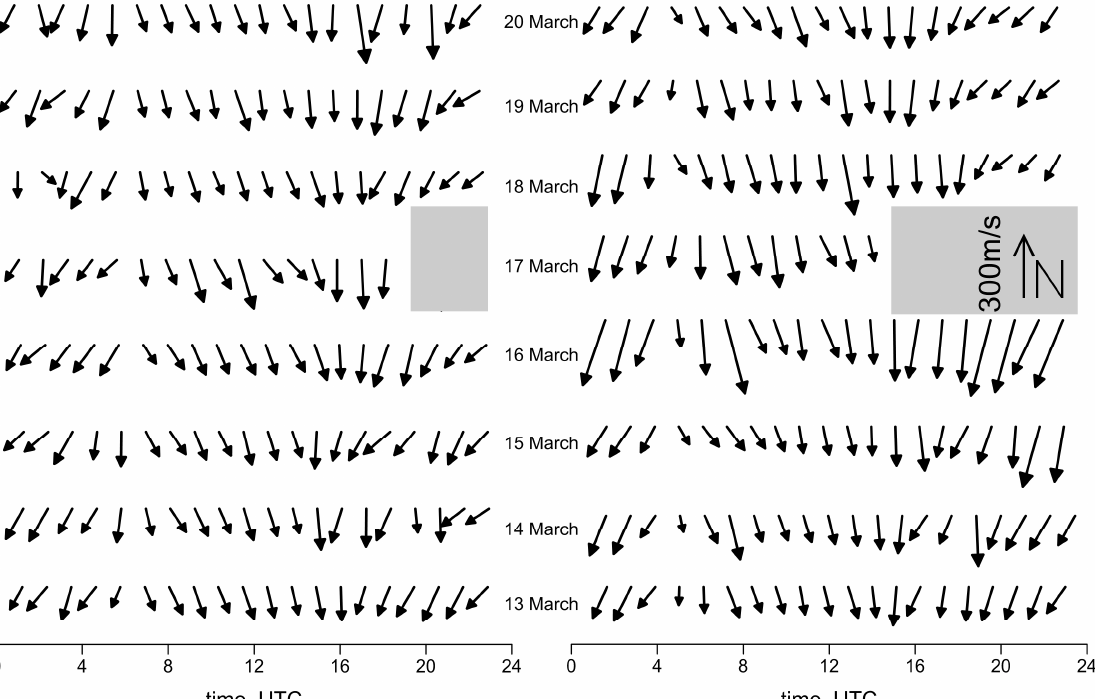
Figure 6. Variations in the speed and direction of motion of the background ionospheric irregularities in the diurnal cycle: year 2013 ( left ) and 2015 ( right ). Two gray zones mask the uncertain rating of direction and speed during the storms. In the right zone, the legend for the speed vector is shown.